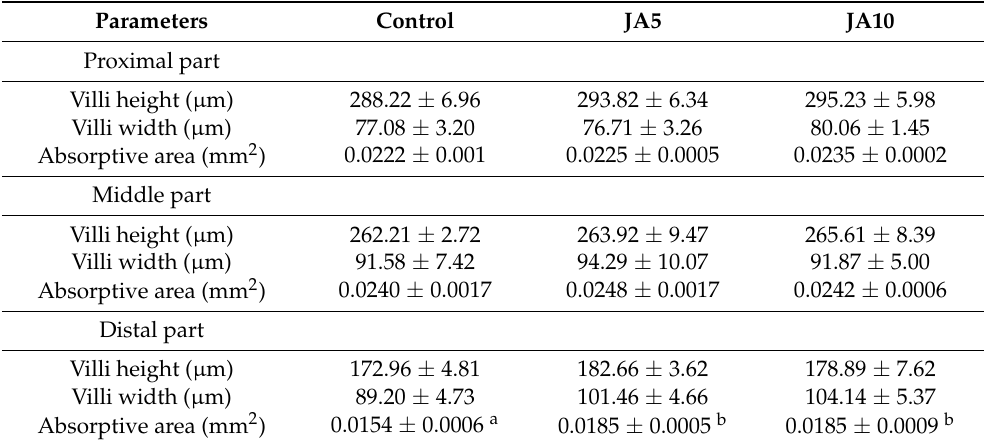
Table 4. Intestinal morphology of red tilapia fed the experimental diets for 4 weeks.